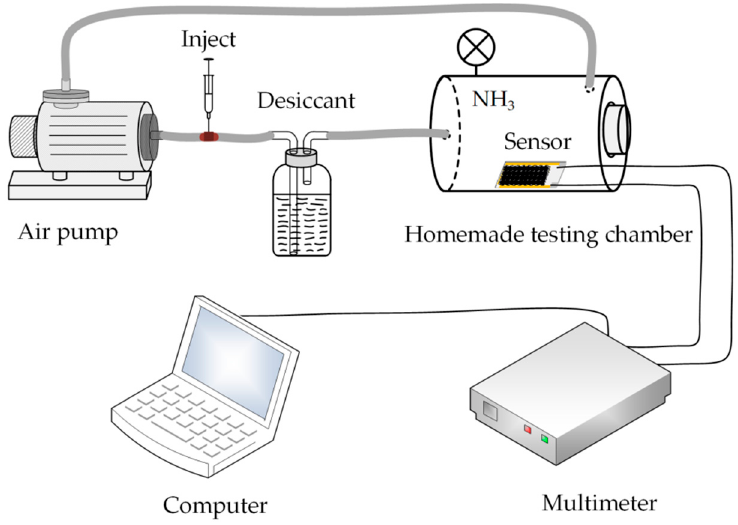
Figure 2. Schematic diagram of the gas detection system.